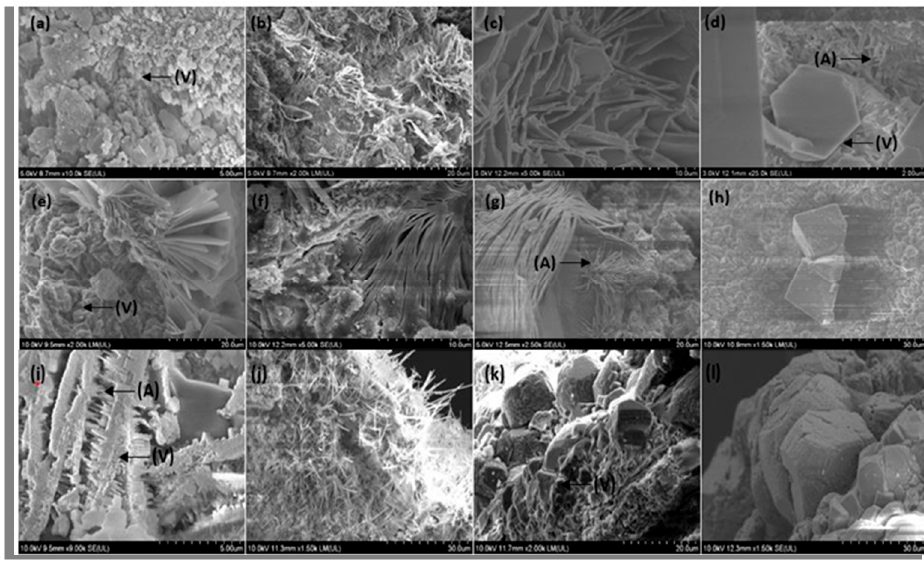
Figure 15. Precipitates observed on the surface of CaAlg capsules after 28 days of self-healing; ( a – d ) N capsules in cement paste; ( e – h ) NS1 capsules in cement paste; ( i ) N capsules in cement mortar; ( j